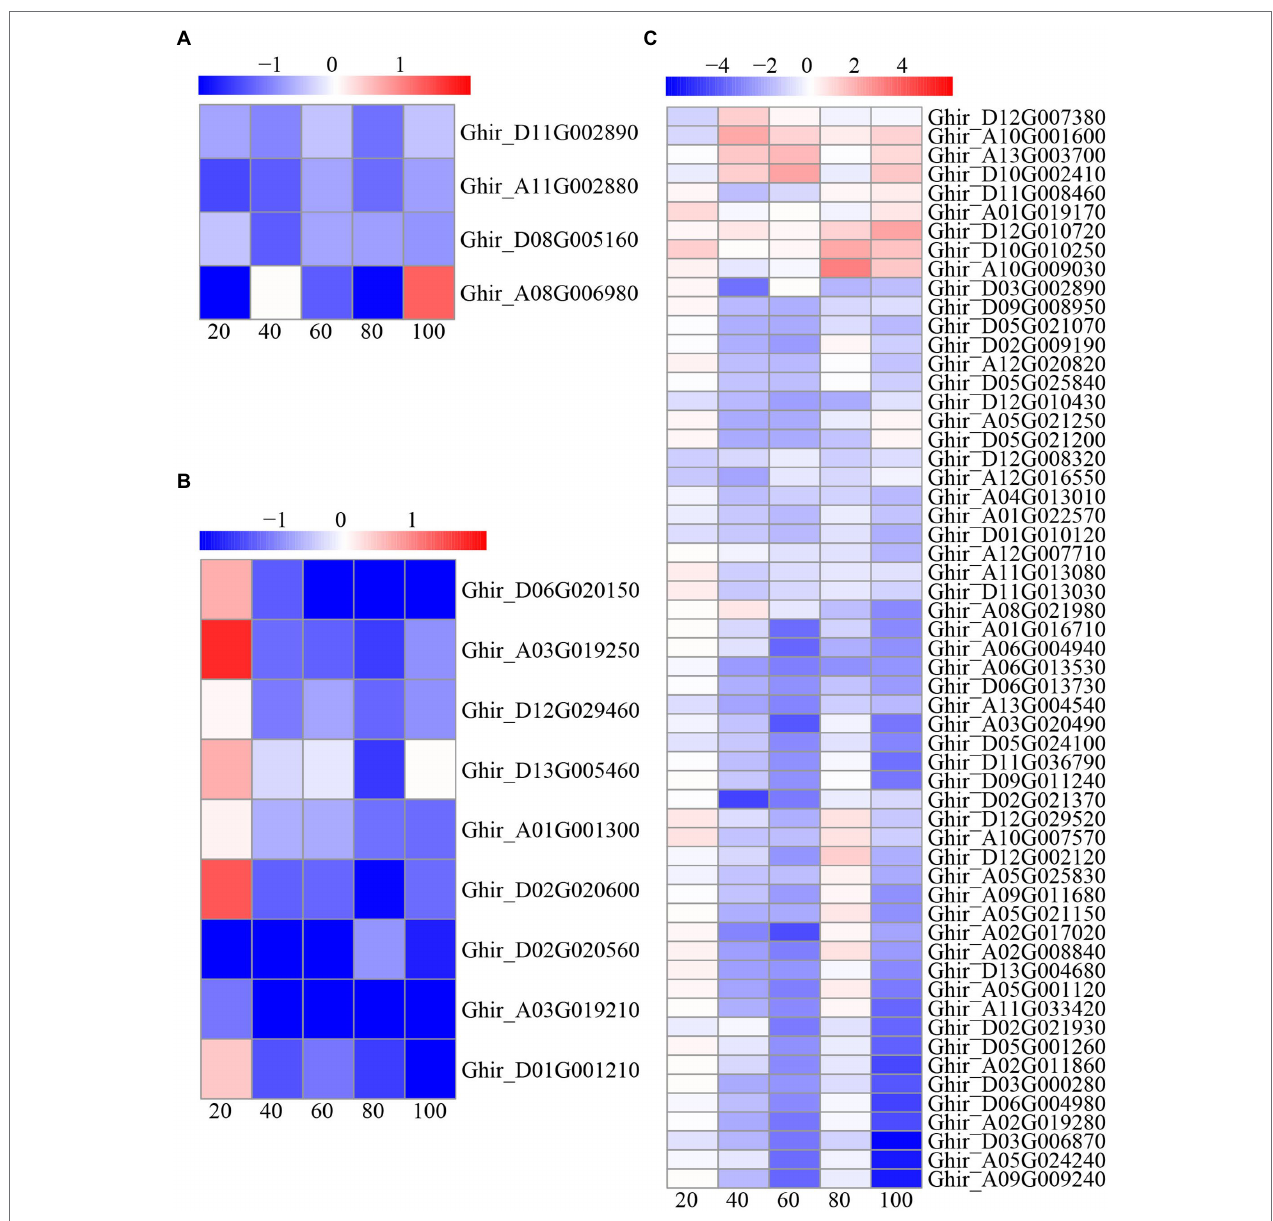
FIGURE 9 | Heat-map illustrating differential expression of apoptosis (A) , caspase (B) , and cyclin (CYC; C ) at 20, 40, 60, 80, and 100 days after emergence. Different scale color represents the size of log 2 fold change